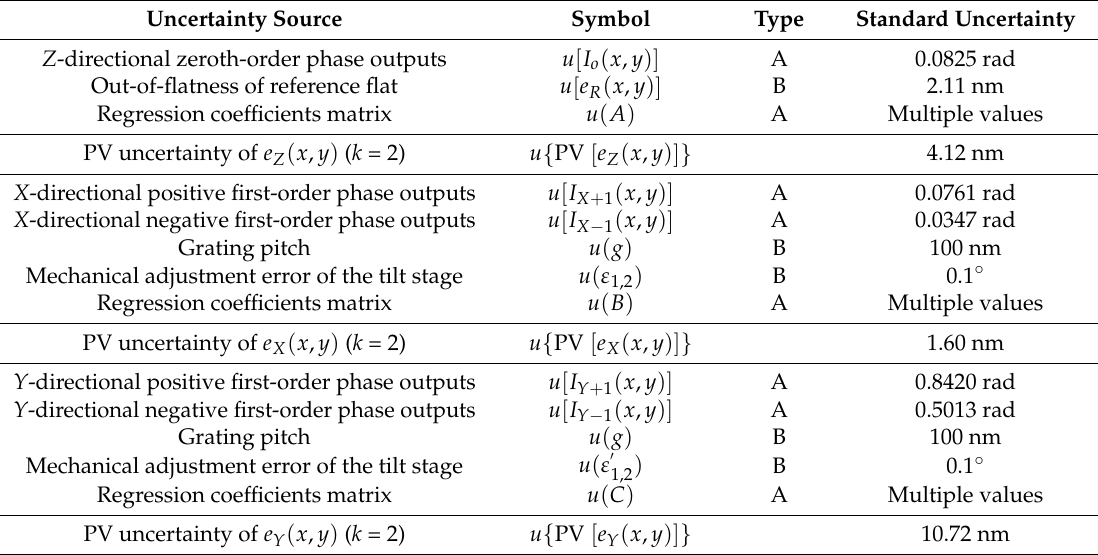
Table 2. Uncertainty